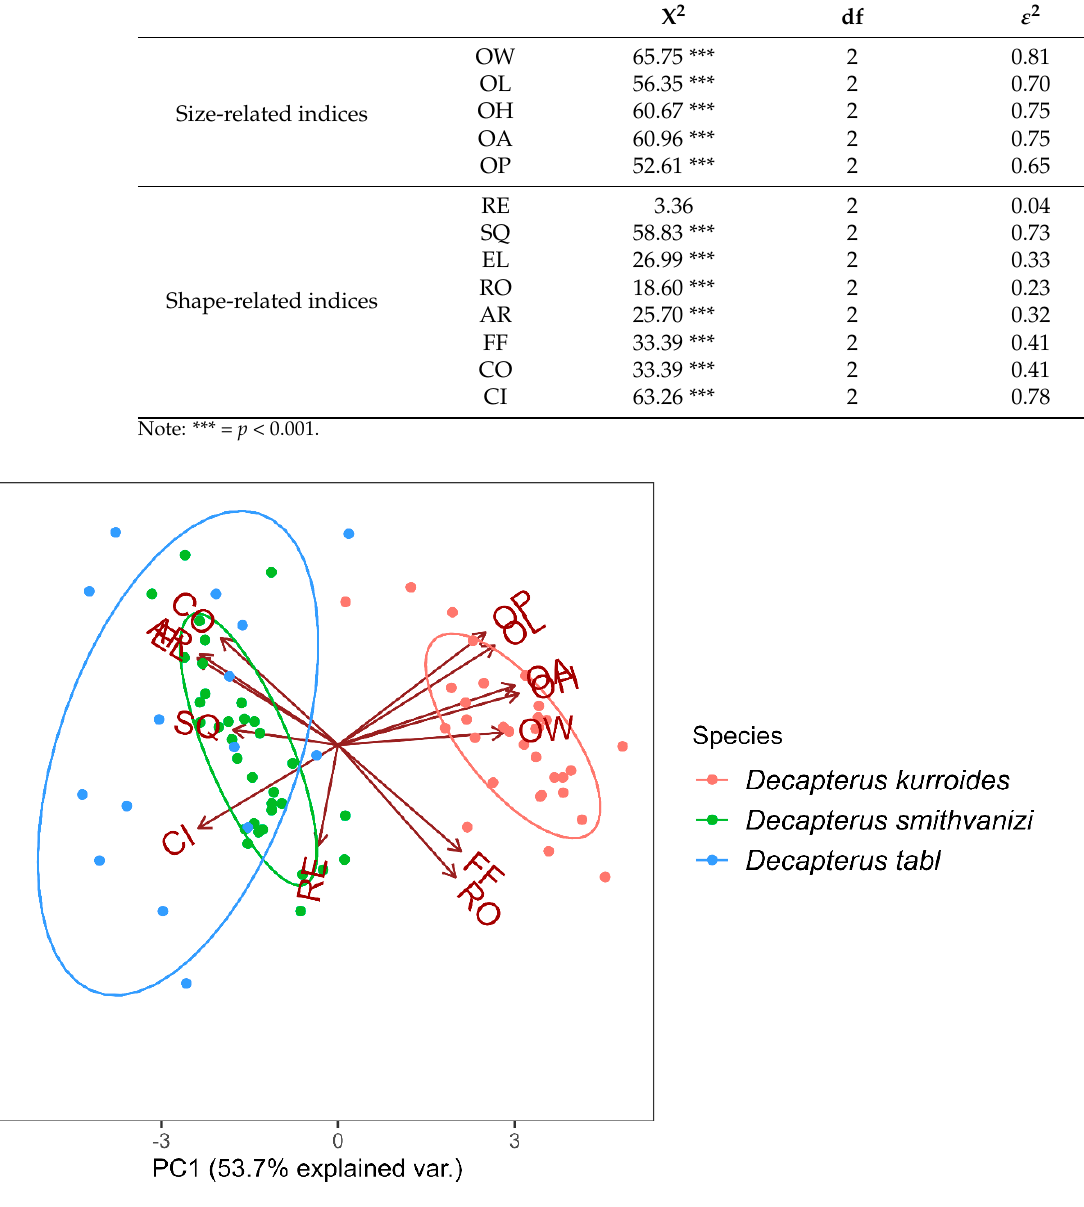
Figure 4. Principal Component Analysis (PCA) plot of size- and shape-related otolith indices (letters at vector ends) from the three redfin Decapterus species from the Sulu Sea, Philippines.